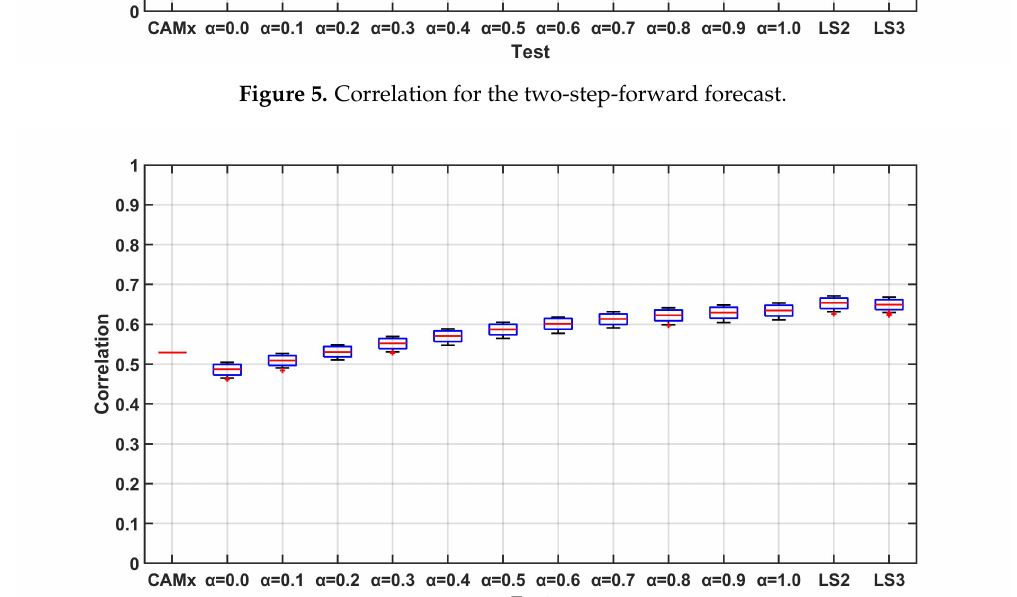
Figure 6. Correlation for the three-step-forward